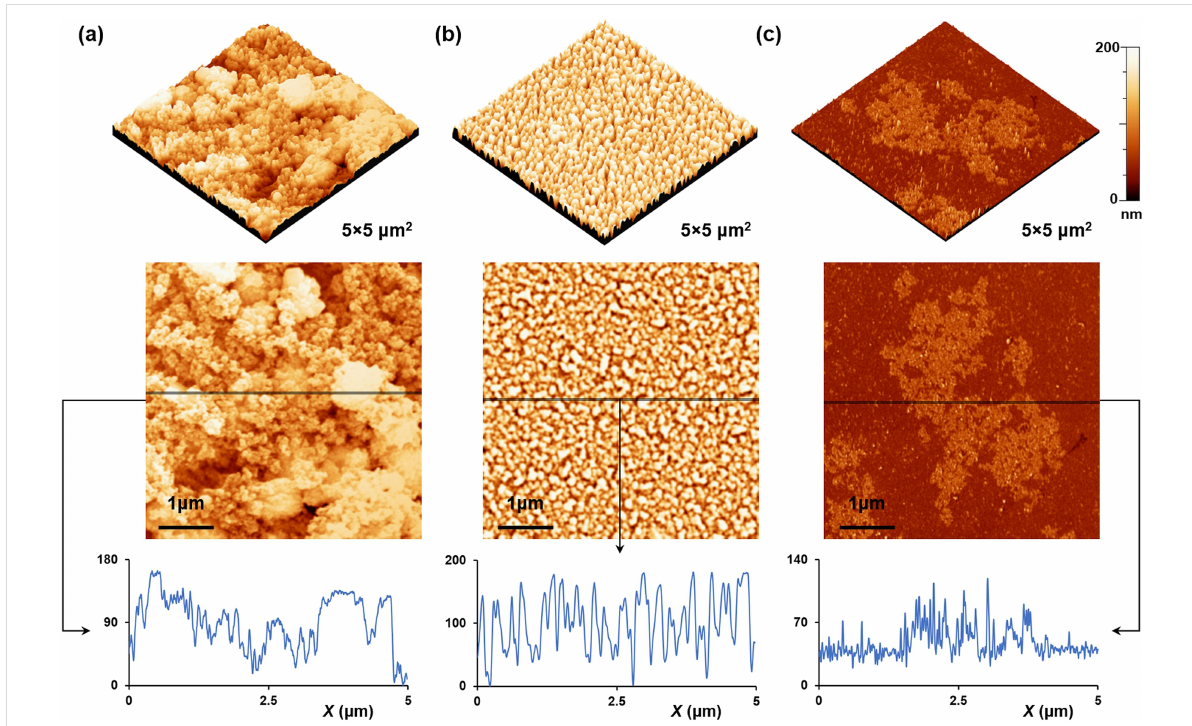
Figure 5: AFM images of the as-prepared BTO nanoparticles (a), BTO-PTh nanoparticles (b), and pristine PTh (c). 3D images showing the surface to- pography, and 2D images along with surface profiles showing the surface morphology of all samples.